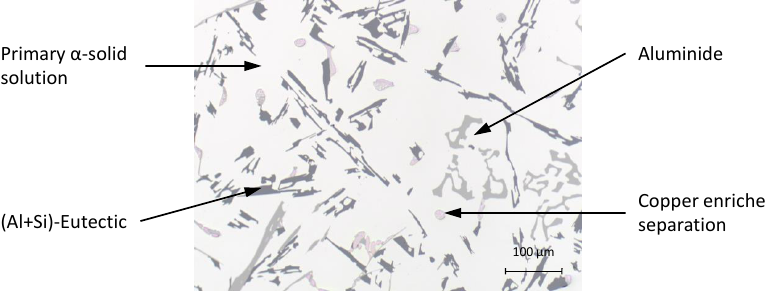
Figure 12. Cross-section of an aluminium alloy probe without a